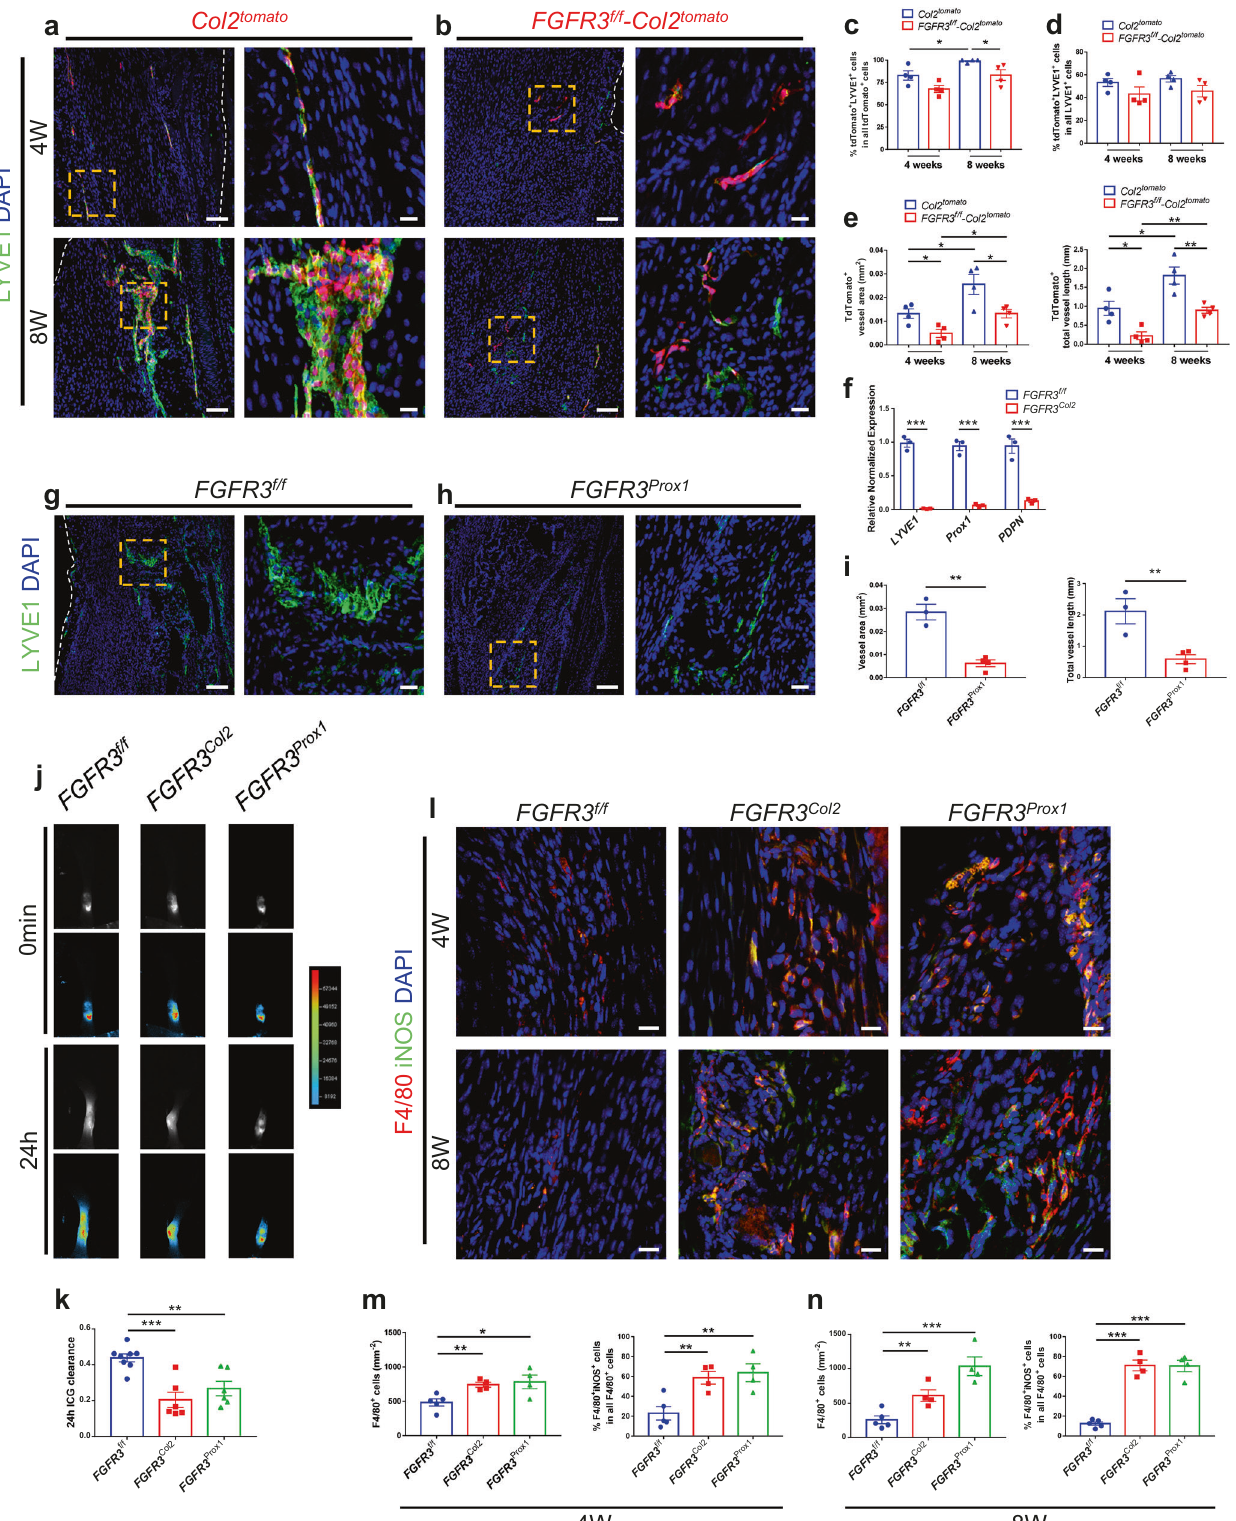
mouse LEC cell line led to upregulated BMPR1a and pSmad1/5 expressions without altered Smad1/5 expression compared with control (CON) (Fig. 5g). Consistently, immunostaining demon- strated that FGFR3 expression in LYVE1 + LECs was remarkably decreased in the repaired tendon of FGFR3 Prox1 mice compared